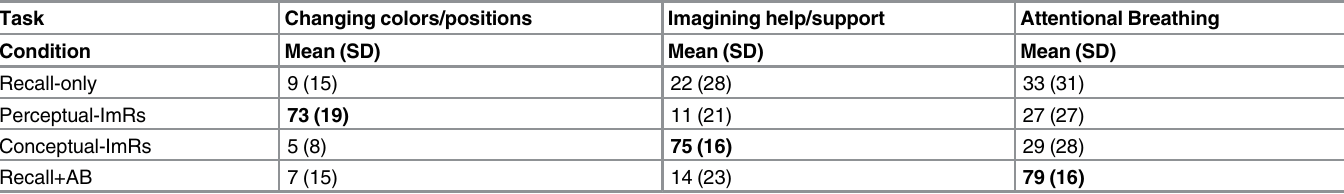
Table 2. Means (SD) of task compliance measures per condition (in mm). Condition-relevant task compliance ratings are in